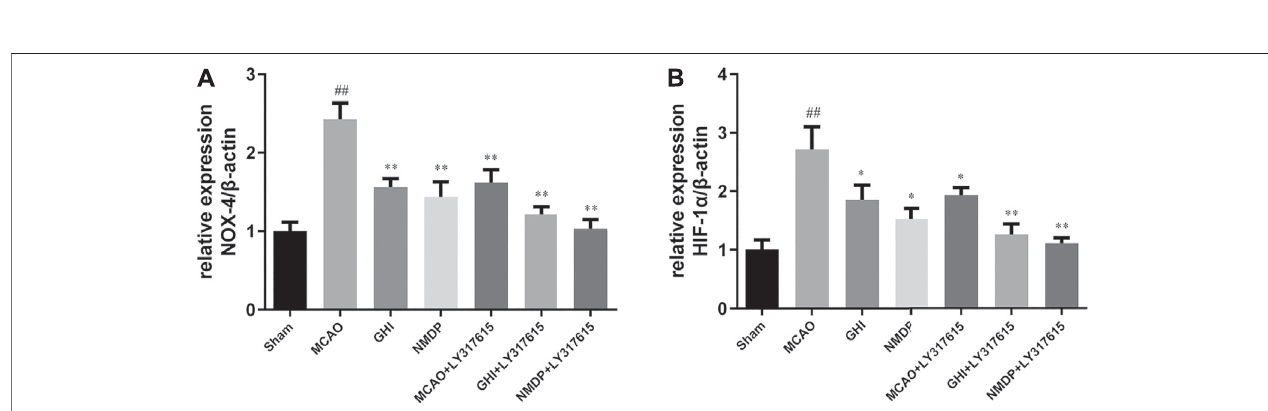
FIGURE 8 | The expression of NOX-4 (A) and HIF-1 α (B) mRNA in rat after I/R for each group ( x ± SD, n (cid:1) 3). #, compared with the Sham group; *, compared with the MCAO group; “ ## ” and “ ** ” means that the p value is less than 0.01; “ # ” and “ * ” means that the p value is less than 0.05.